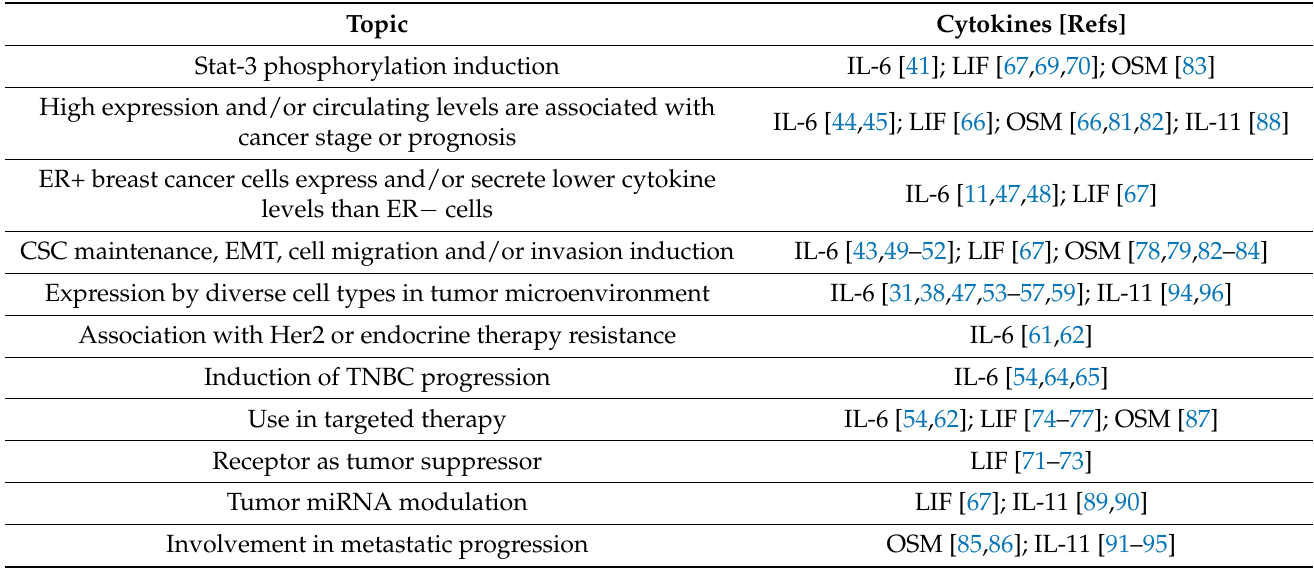
Table 1. Comparative summary. Most relevant studies, cited in this review, about IL-6 cytokine family role in breast cancer development and